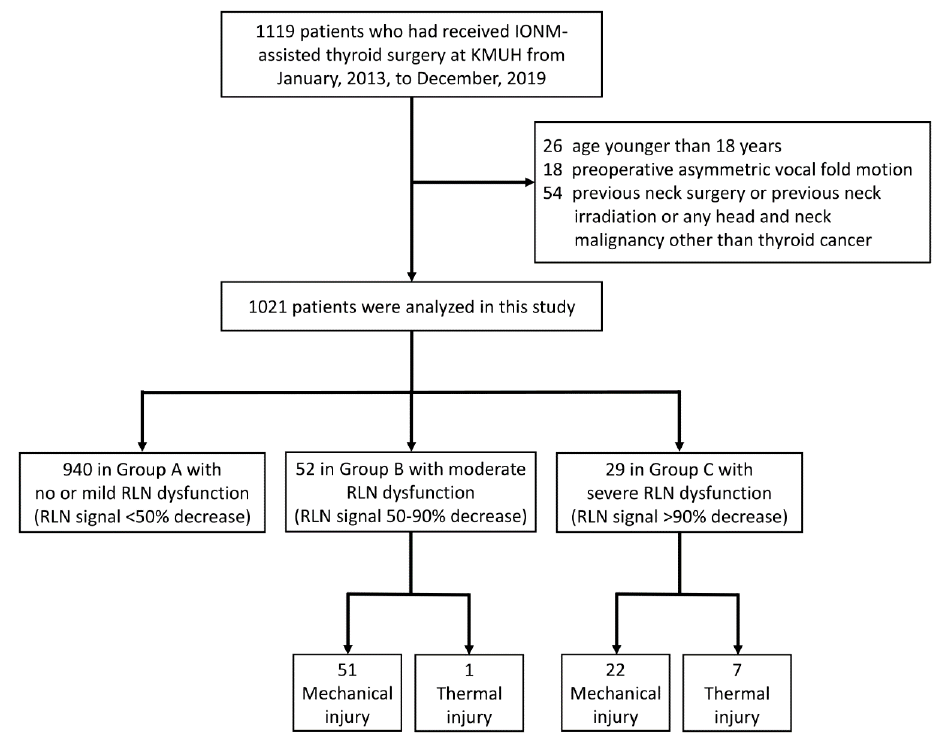
Figure 1. Flowchart of procedure for inclusion and exclusion of patients. Abbreviations: IONM = intraoperative neuromonitoring; RLN = recurrent laryngeal nerve.